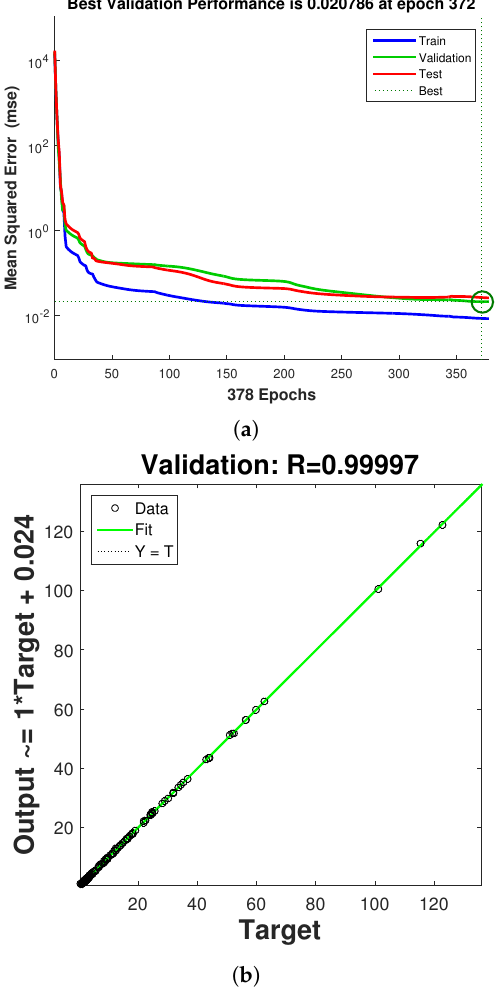
Figure 16. NN performance with different iterations for different data sets ( a ) and regression plot for validation data set ( b